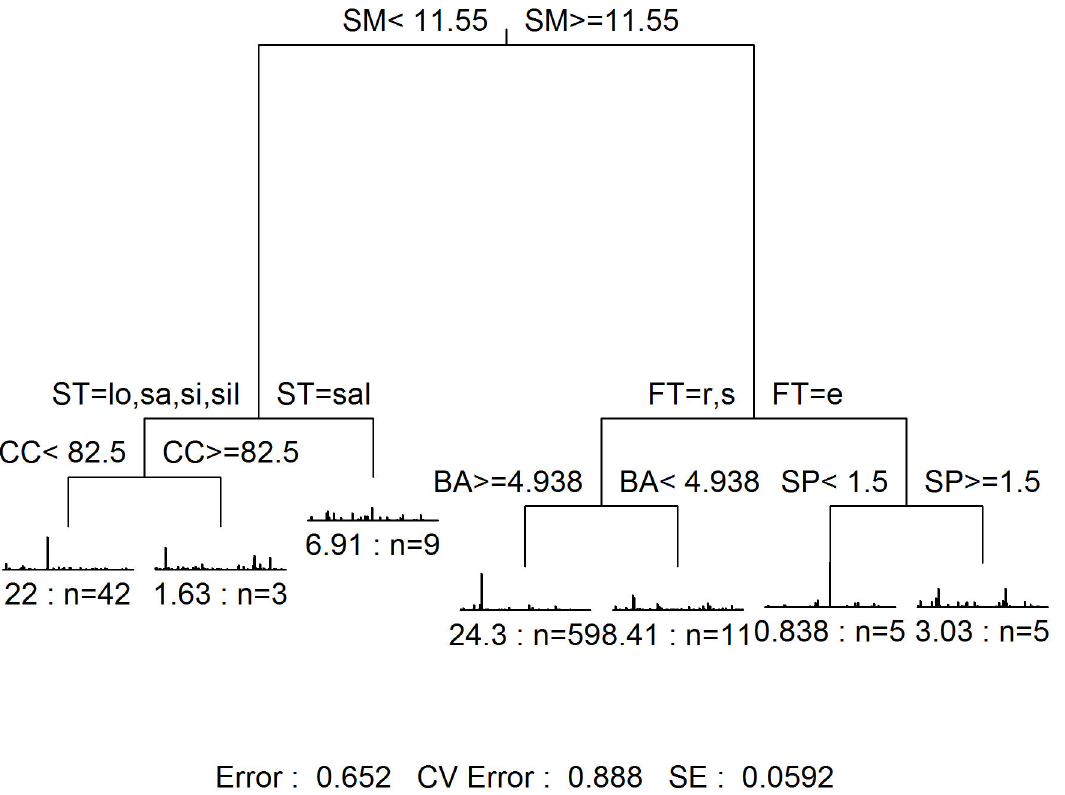
Figure 7. The solution of MRT tree with 7 groups for all species. Abbreviations: SM (soil moisture), CC (canopy coverage), ST=lo,sa,si,sil (soil texture in loam, sand, silt and silty loam), ST=sal (soil texture in sandy loam), BA (basal area of trees per square meter), FT=r,s (forest type in rubber plantation and secondary forest), FT=e (forest type in eucalyptus plantation), SP (slope position), # : n (relative error : number of sites), CV (cross-validation), SE (standard error).